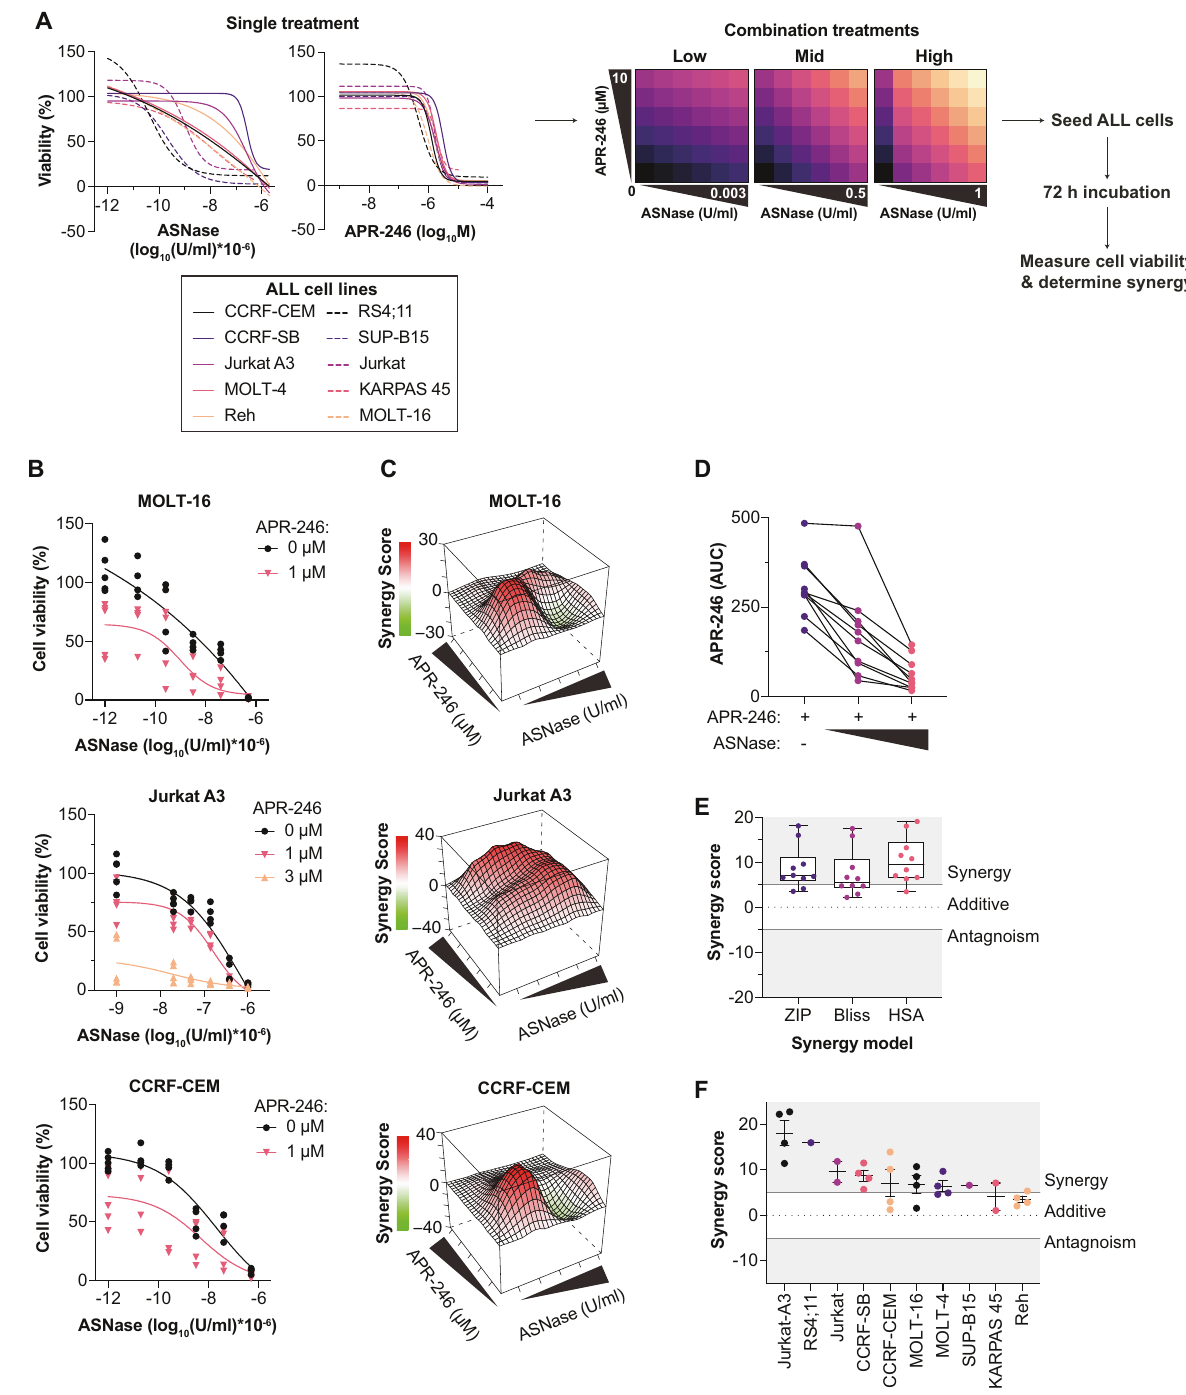
Fig. 4 APR-246 synergizes with ASNase in ALL cells. A Single treatment ( n = 2 – 7) and experimental overview of combination treatments. Cell viability as assessed by resazurin after 72 h single treatment with either asparaginase (ASNase) or APR-246. Three different ASNase treatment groups (low, mid, high) for the combination treatments were used; APR-246 concentrations were the same for all cell lines. B Cell viability as assessed by resazurin after 72 h of increasing concentrations of ASNase in combination with APR-246. Each dot indicates an individual experiment. C Synergy landscape determined by ZIP model over APR-246 and ASNase concentrations of one representative experiment. Concentrations of APR-246 and ASNase are as in Fig. S4A. D Cell viability (area under the curve [AUC]) as assessed by resazurin after 72 h of APR-246 alone or with two different concentrations of ASNase (0.04 – 0.05 and 0.4 – 0.5 U/ml for all cell lines except for RS4;11 and SupB15 that were treated with 0.009 and 0.003 U/ml). Each dot indicates one ALL cell line. See Table S5 for more details and n for each cell line. E Box-and-whisker plot of synergy scores of most synergistic area determined by three different synergy models. Central band indicates median, boxes indicated 25th and 75th percentile, and whiskers show min. and max. values. Each dot indicates one ALL cell line. See Table S6 for more details, including n for each cell line. F Synergy score of most synergistic area determined by the ZIP model in 10 different ALL cell lines after ASNase treatment + / − APR-246 for 72 h. Each dot indicates one